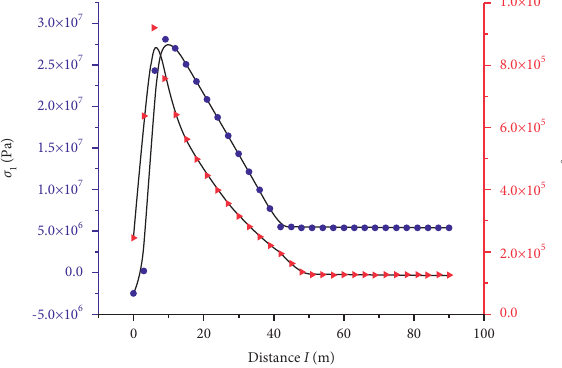
e , and I when the main roof is 1 , U